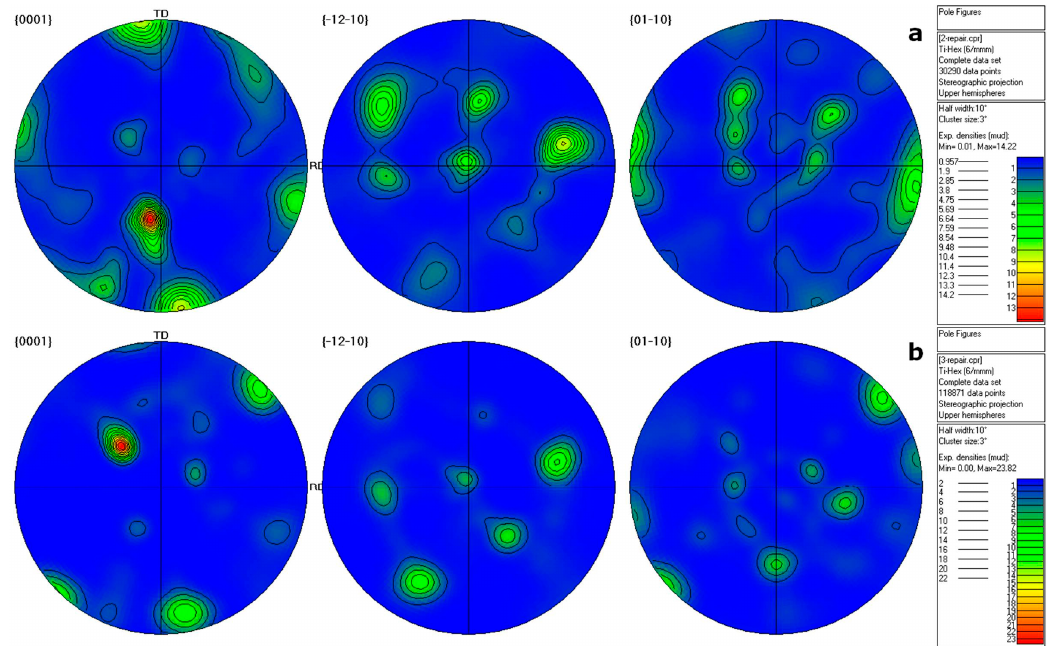
Figure 6. Pole figures of the ( a ) hot-rolled and ( b ) annealed β 20C alloys.